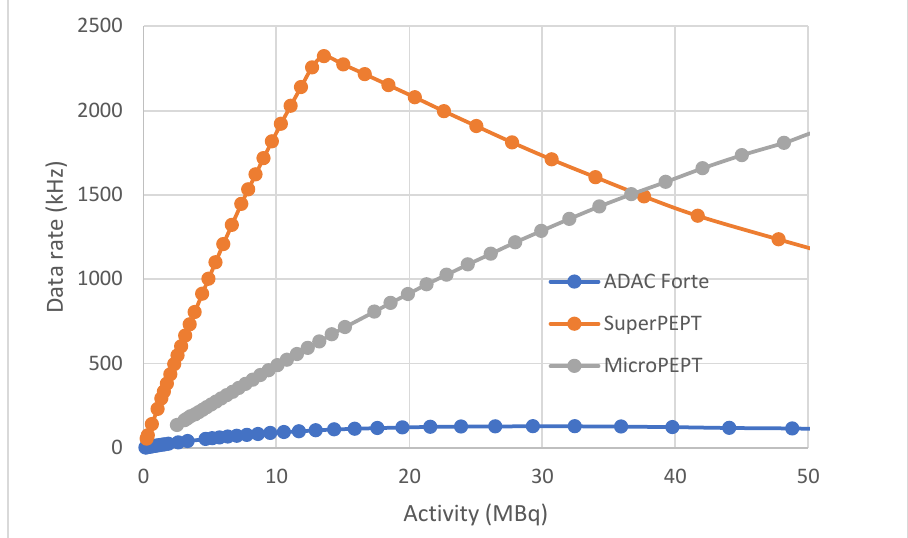
Figure 8. Comparison of the data rates recorded for central 11 C sources of varying activity using the three cameras. For SuperPEPT and MicroPEPT, the curves show the rate of true coincidences, obtained as the difference between the measured rates of prompt and delayed coincidences; for the ADAC Forte the total prompt coincidence rate is plotted.